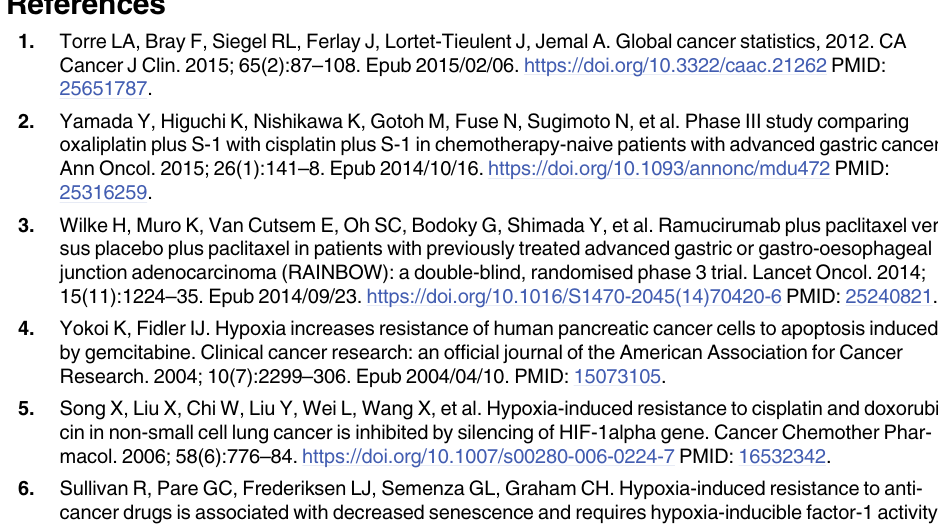
S1 Fig. Correlation between CD3+/CD4+ T cell number and expression of miR-210 or miR-382. S2 Fig. Correlation between PD-L1 status and miR-210 or miR-382 expression. S1 Table. Baseline characteristics of 183 patients. S2 Table. Baseline characteristics of 60